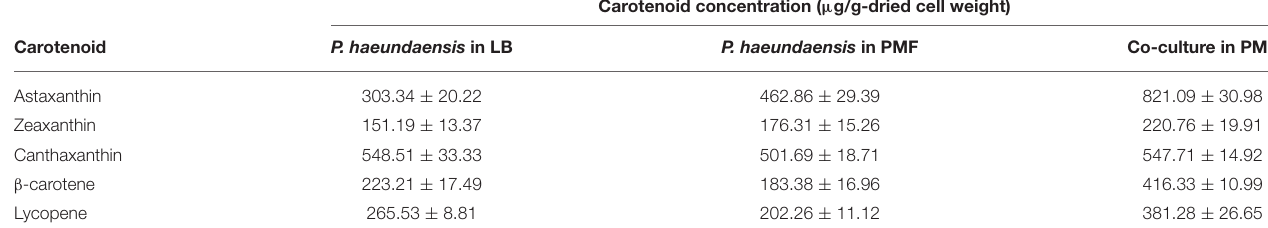
TABLE 2 | Carotenoid concentrations according to culture medium and the co-culture of Paracoccus haeundaensis and Lactobacillus fermentum . Carotenoid concentration ( µ g/g-dried cell weight)